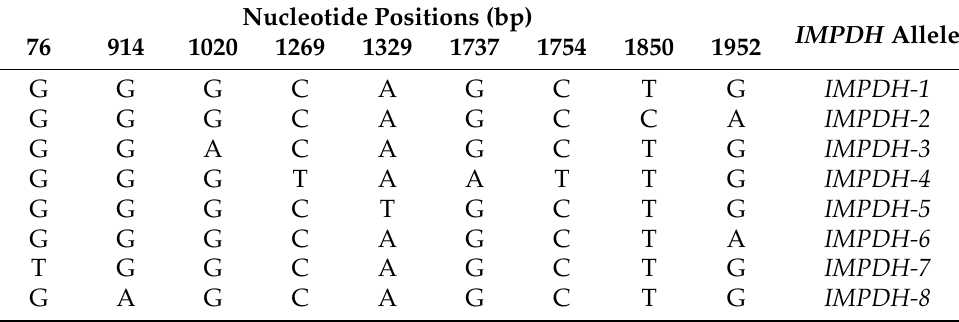
Table 4. Pneumocystis jirovecii IMPDH alleles defined in the present